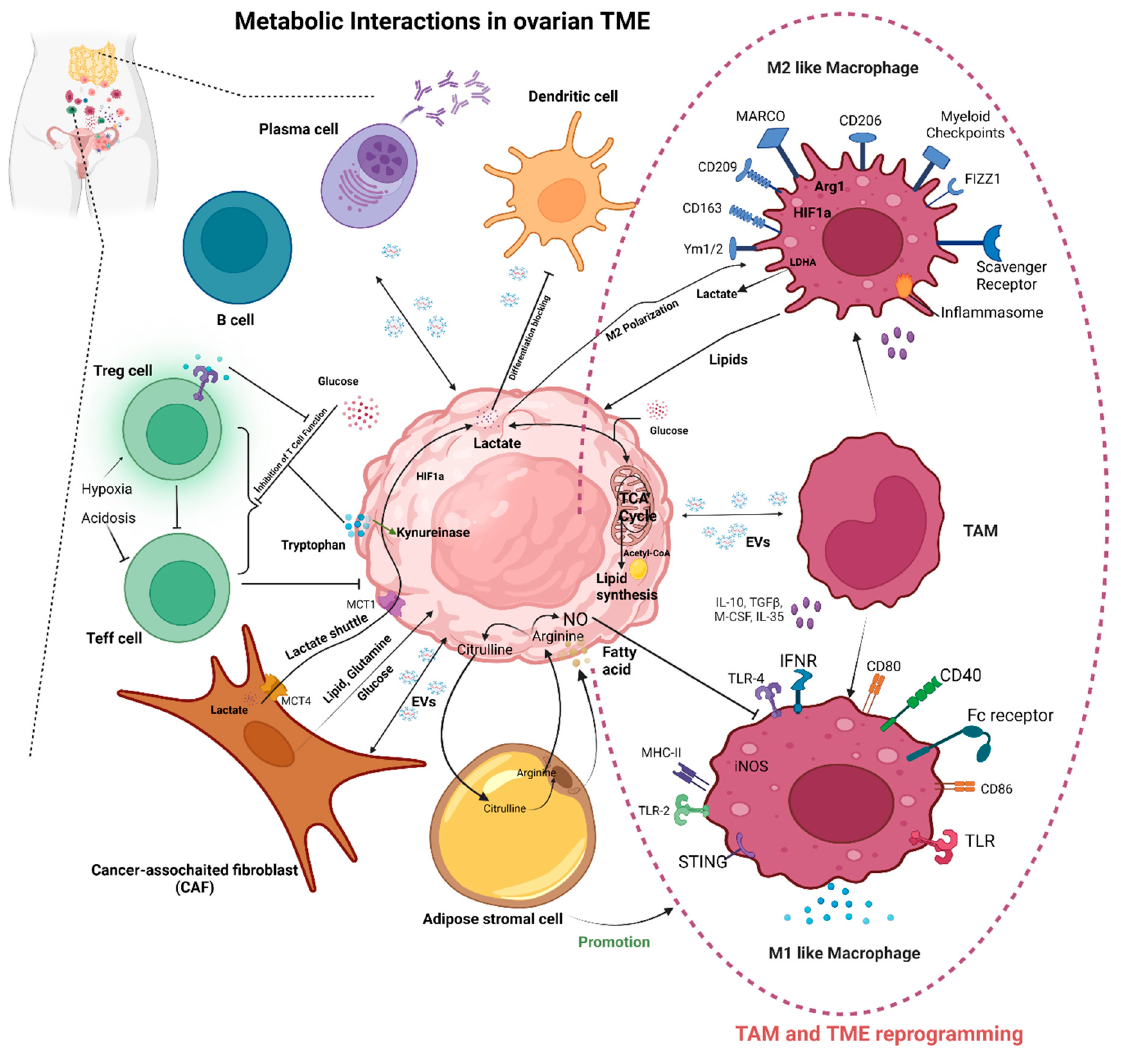
Figure 1. A summary of the metabolic interactions and reprogramming in the TME between can- cer and non-cancer cells, focusing on TAM metabolic reprogramming, including EVs. Ovarian cancer cells consume oxygen and nutrients (glucose, glutamine, etc.) from the extracellular matrix, primarily through glycolysis, rather than through the TCA cycle of OXPHOS in the mitochondria, which provides ATP for cancer cell growth, even under aerobic conditions. During TAM and TME reprogramming, several signals, including complement, inflammasome activators, ligands for scavenger receptors MARCO and CD206, and myeloid checkpoints, can place macrophages in a pro-tumor mode. OXPHOS, oxidative phosphorylation; CAF, cancer-associated fibroblasts; Teff, effector T cells; Treg, regulatory T cells; Gln, glutamine; NO, nitric oxide; ARG1, arginase 1; MCT, monocarboxylate transporters; EVs, extracellular vesicles. Created with BioRender.com. Accessed on 11 September 2022.